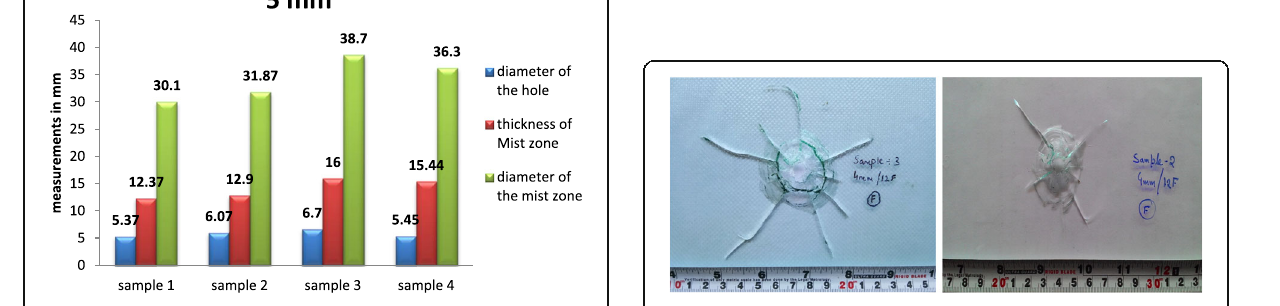
Fig. 7 Graphical Representation of Measurements for 5 mm Glass Pane